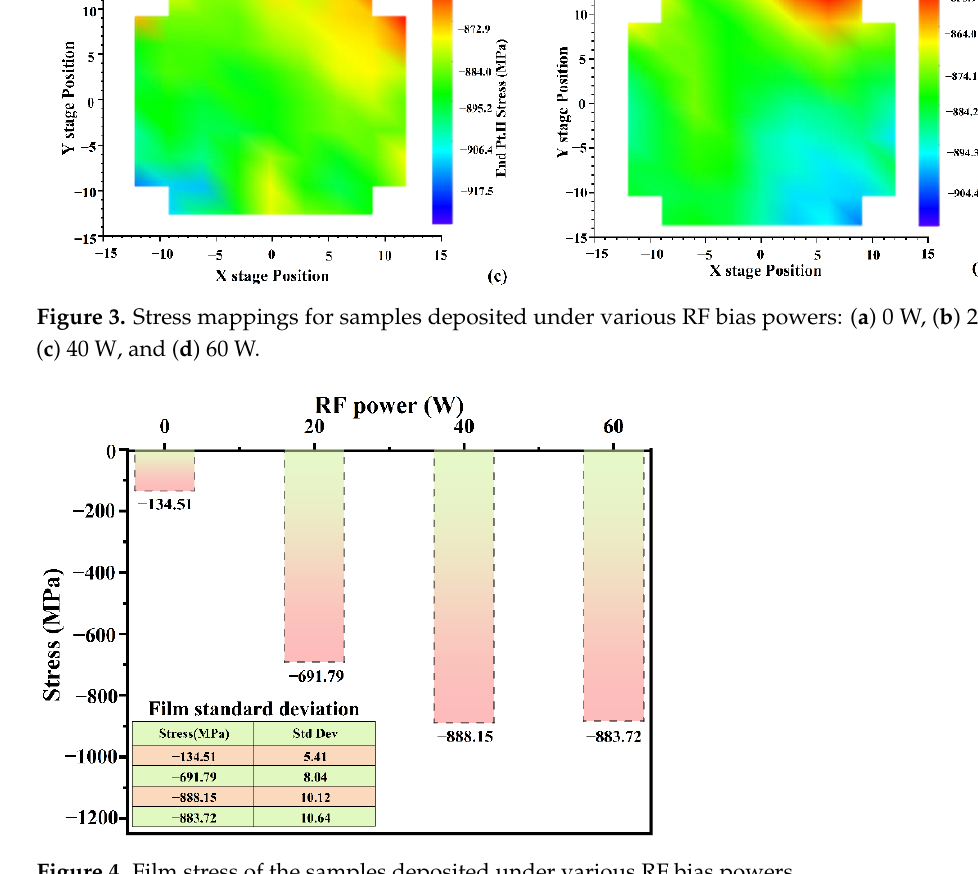
Figure 4. Film stress of the samples deposited under various RF bias powers.